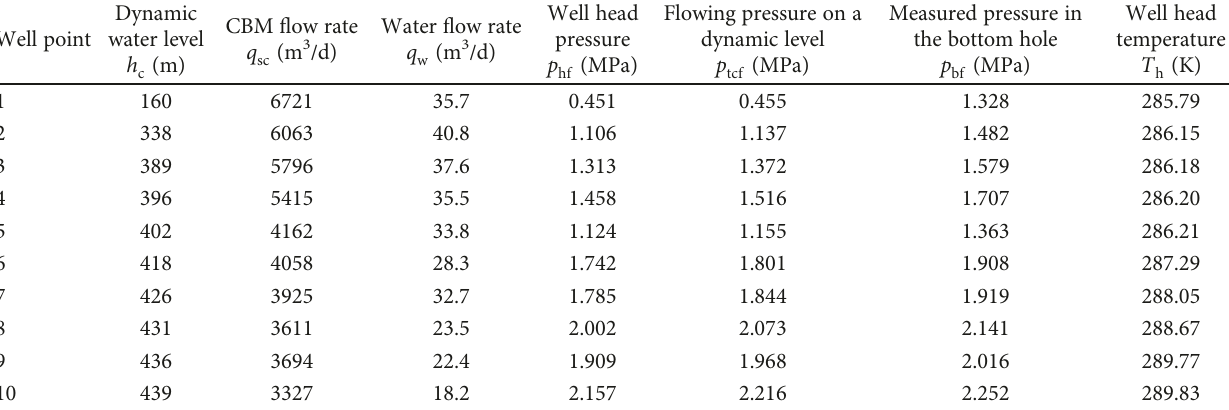
Table 1: Measured parameters and independent variables for the CBM producing process.